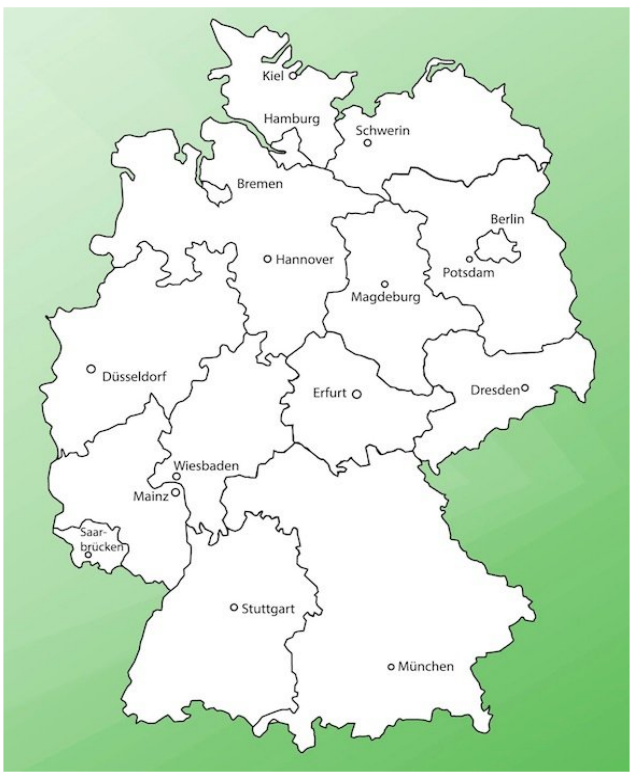
Figure 1. Germany